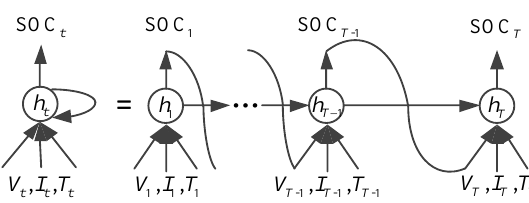
Figure 3. A single hidden layer node in the GRU-RNN unfolded in time.